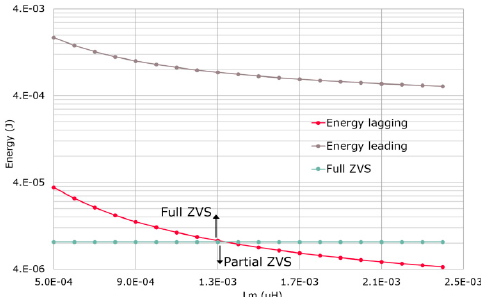
Figure 10. Available energy for the zero-voltage-switiching (ZVS) transitions depending on the value of the magnetizing inductance with the converter operating at 10% of the load.